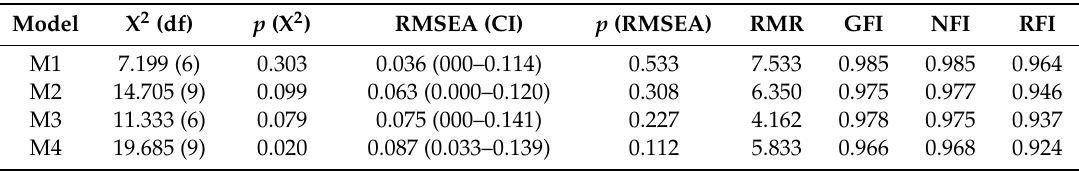
Table 1. Goodness-of-fit indicators for the hypothesized theoretical models.